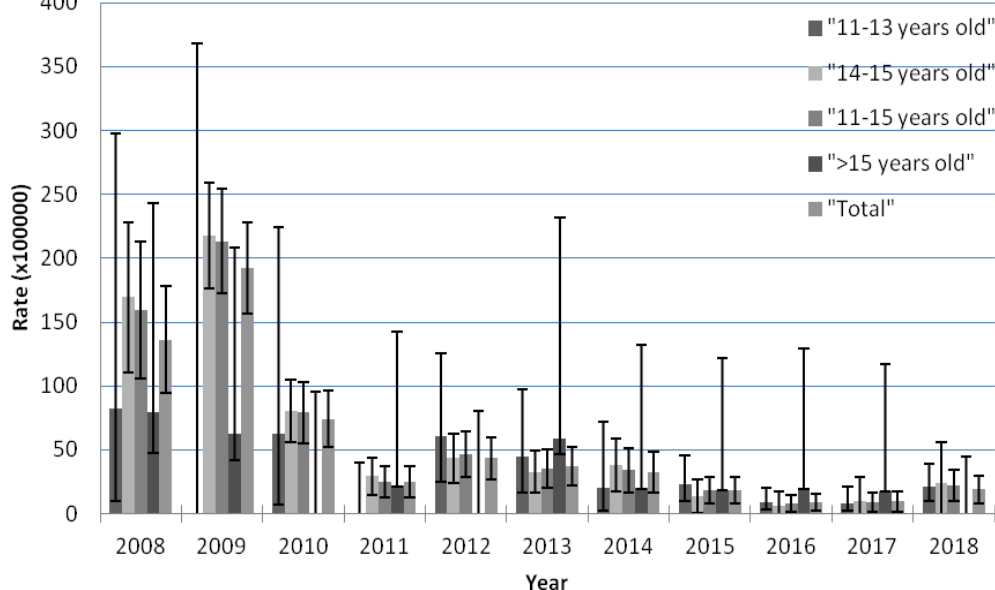
Figure 2. Trends in AEFI reporting rates following HPV vaccines in the Valencian Community, Spain, according to the joinpoints identified by the analysis by different age groups. ( a ) 11–13 years old group, no joinpoint was detected; ( b ) 14–15 years old group, a joinpoint was detected in 2011; ( c ) > 15 years old group, no joinpoint was detected; ( d ) for all the groups, a joinpoint was detected in 2011.